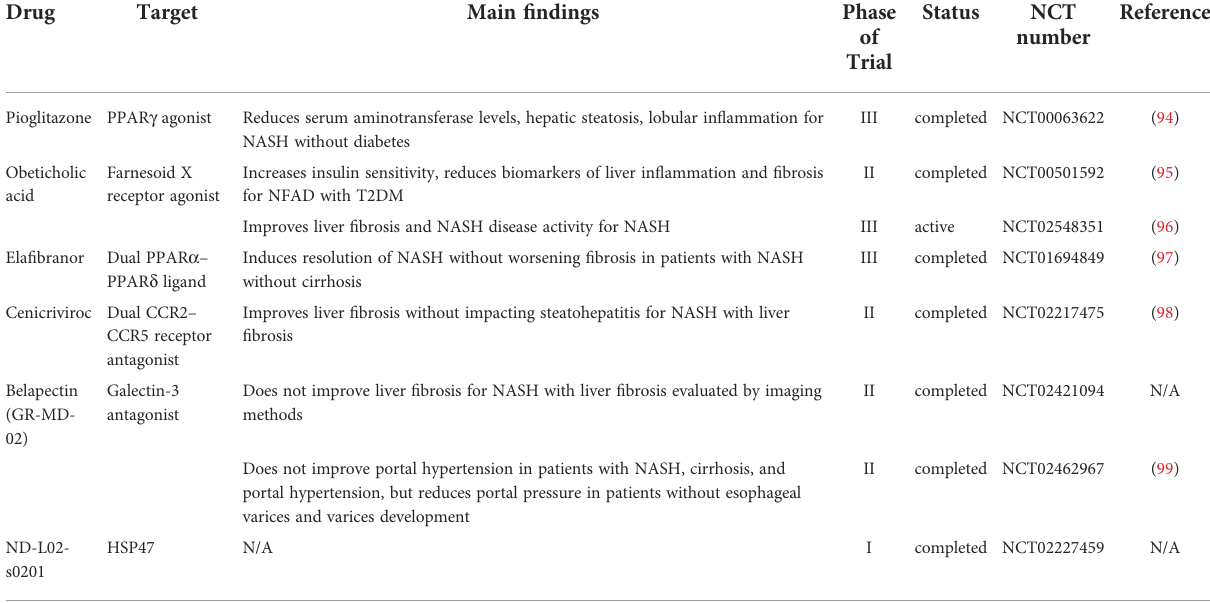
TABLE 1 Clinical trials of drugs targeting HSC activation.